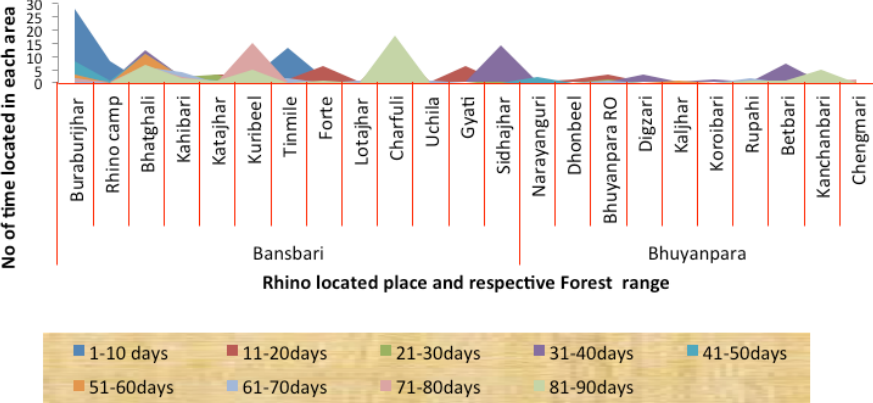
Figure 9. Colonization pattern of the 5 th group of rhino